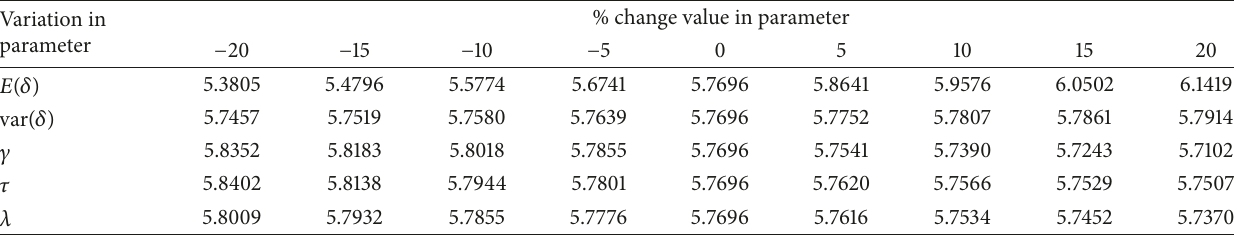
Table 2: Effects of changing four categories of parameters on 𝑃 𝑇 .